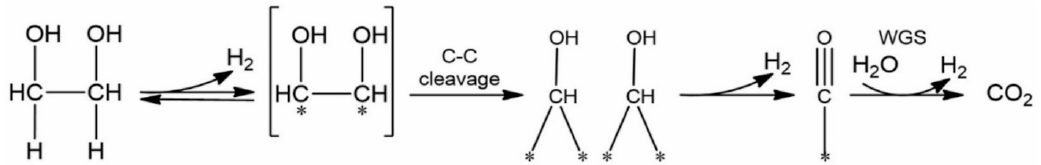
Figure 2. Mechanism underlying APR conversion of a diol component into hydrogen (reprinted with permission from ref. [43] Copyright 2022 Elsevier).